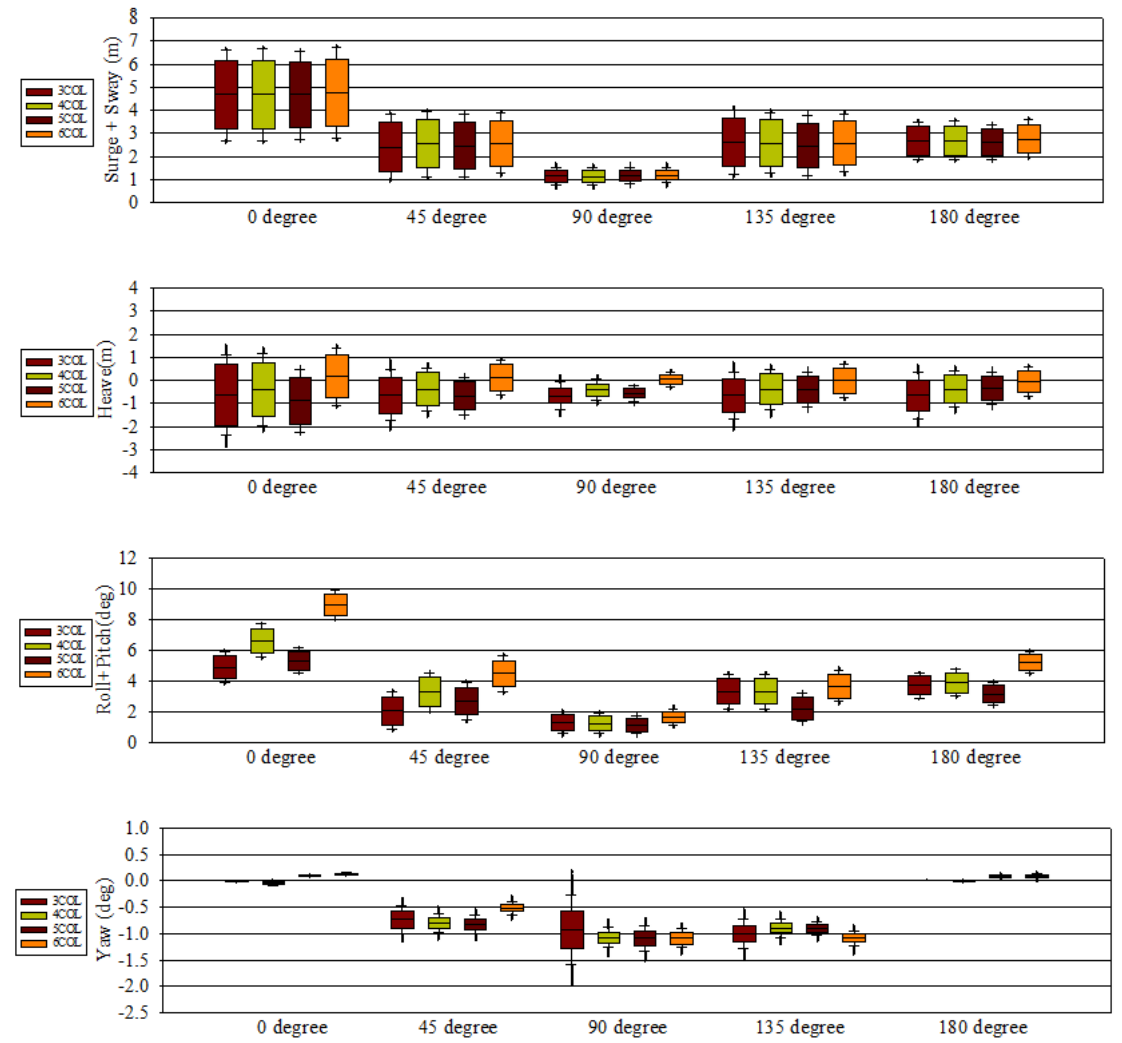
Figure 21. Alignment case stability analysis results using fully ‐ coupled simulation.